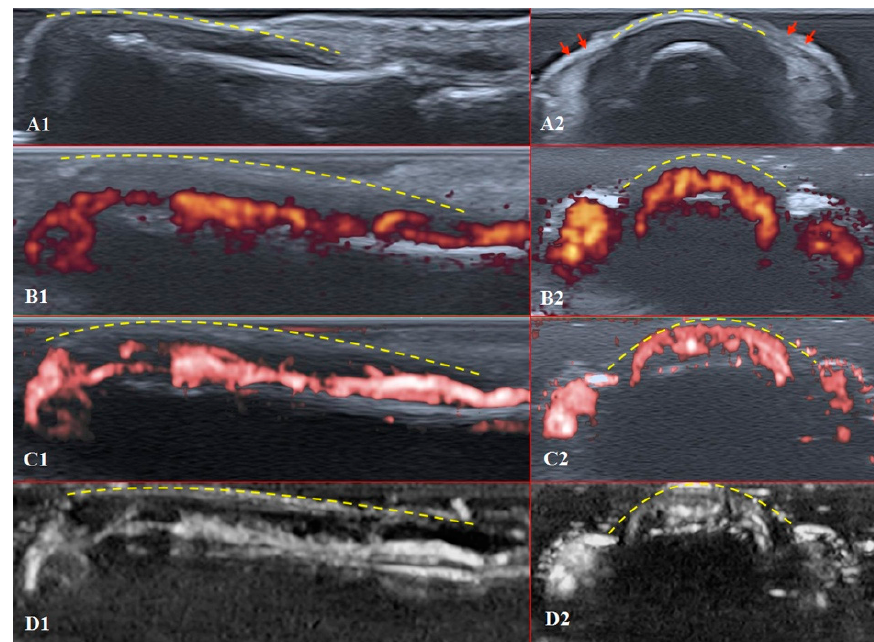
Figure 4. Ultrasound images of the healthy fingertip of the second finger of a hand: ( A1 , A2 ) B mode/grayscale; ( B1 , B2 ) PD; ( C1 , C2 ) cSMI; ( D1 , D2 ) mSMI. The yellow dotted lines mark the nail. Sagittal scans ( B1 – D1 ) in the midline of the fingertip show vascularity from the deep layers of the nailbed to the end of fingertip pulp. The main landmarks for all transverse scans ( B2 – D2 ) are lateral nailfolds ( A2 red arrows), which unite in the middle of the proximal nailfold and become a convex line.